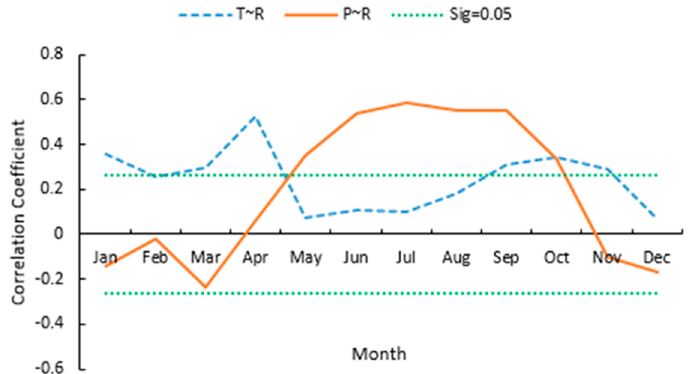
Figure 6. Correlation between monthly precipitation and runoff and temperature and runoff in SRYR; T ‐ R is correlation between temperature and runoff depicted by a dashed blue line; P ‐ R is correlation between precipitation and runoff depicted as solid orange line; significance level 0.05 is depicted as green dot line, positive correlation above green line is statistically significant.